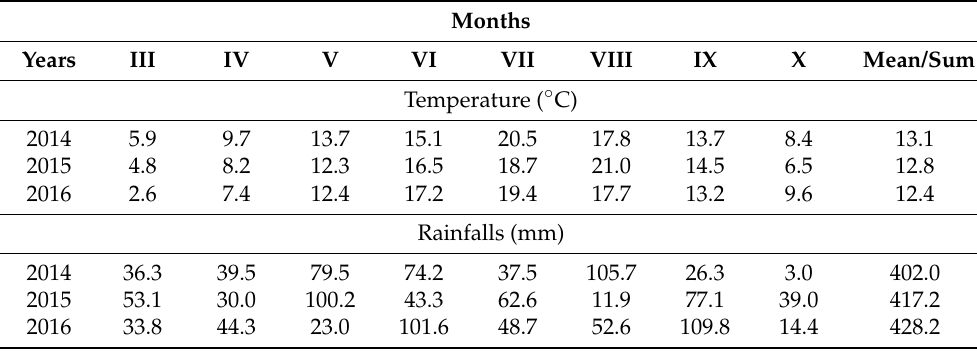
Table 1. Characteristics of hydrothermal conditions, on the basis of data provided by the Institute of Meteorology and Water Management in Warsaw, the Hydrological and Meteorological Station in Siedlce (Poland).